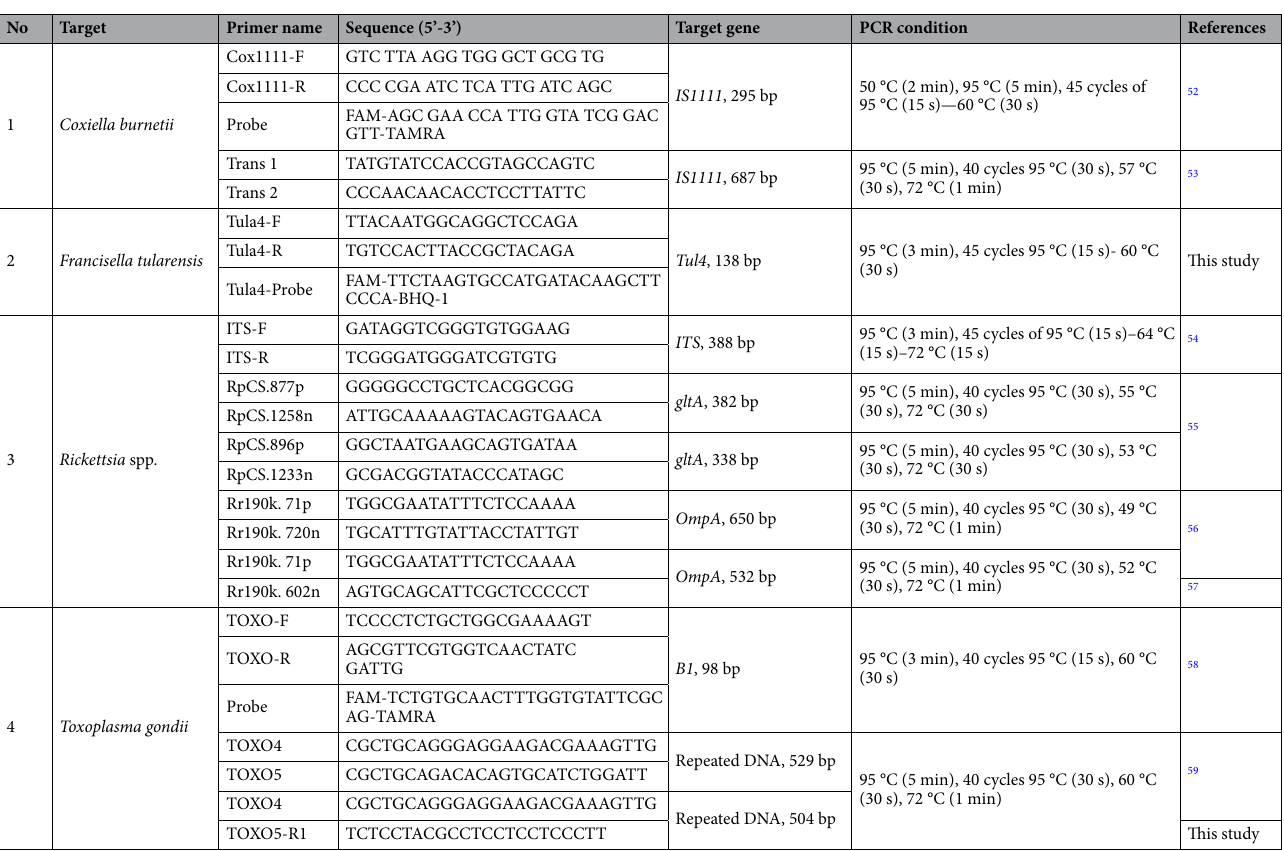
Table 3. Primers and PCR conditions for the detection of tick-borne